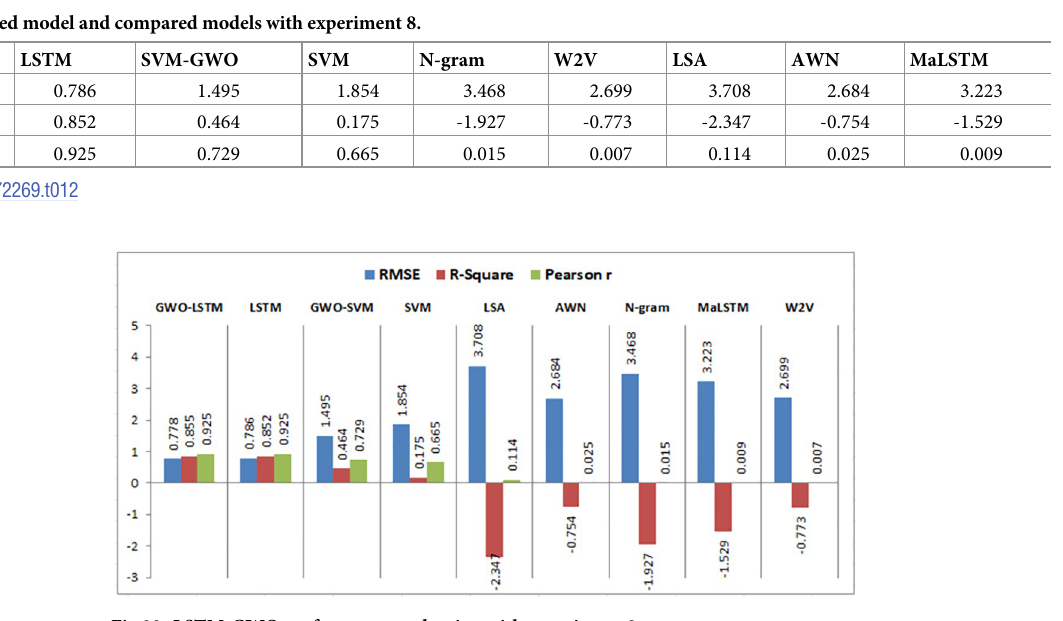
Fig 30. LSTM-GWO performance evaluation with experiment